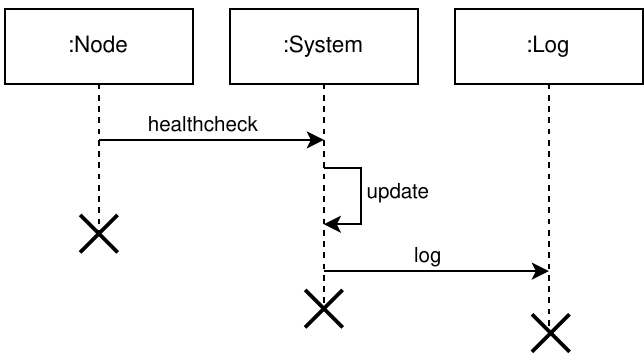
Figure 4. High level health-check protocol